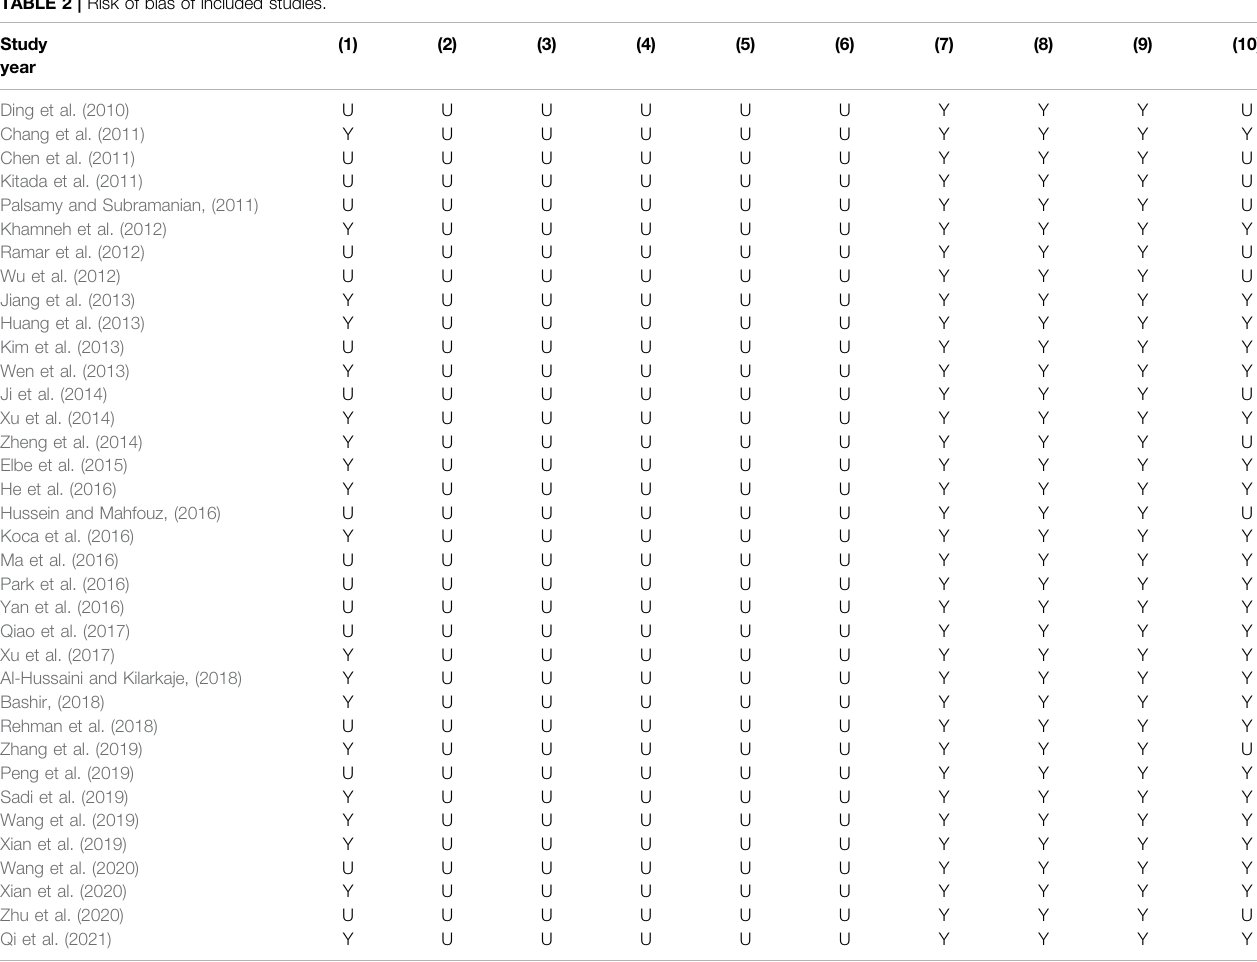
TABLE 2 | Risk of bias of included